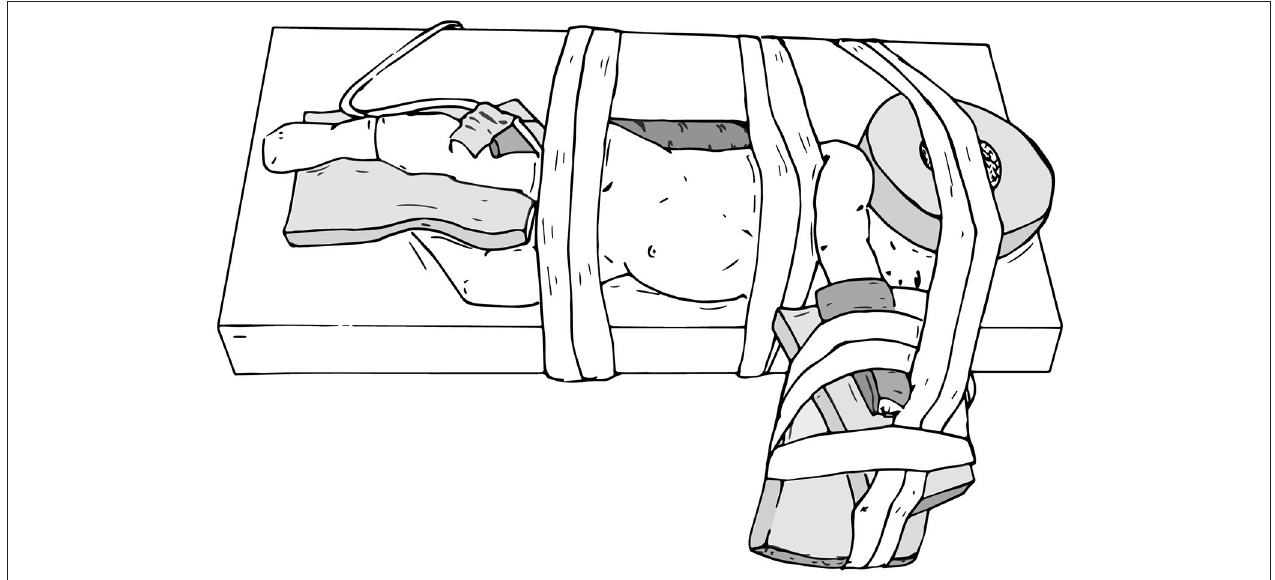
FIGURE 6 | Modified flank positioning with arms placed on an arm board across the body.